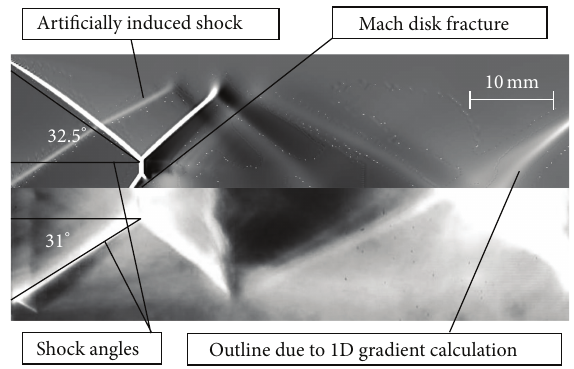
Figure 14: Comparison of CD schlieren images in the OX flow con- dition.